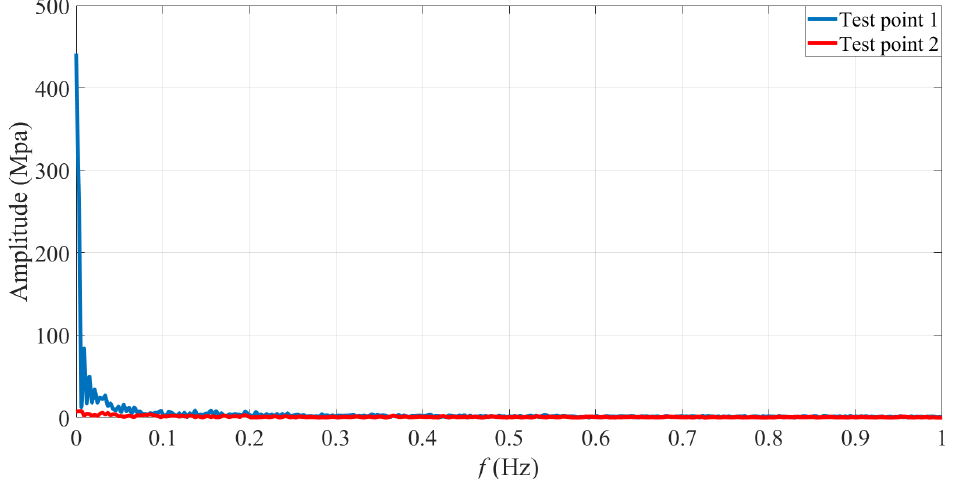
Figure 15. Amplitude spectra of the maximum principal stress on test points 1 and 2.